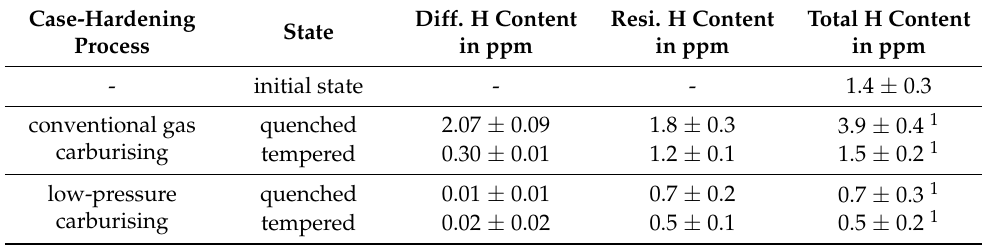
Table 3. Results of carburisation process, material investigated: 18CrNiMo7-6 (III), edge area.